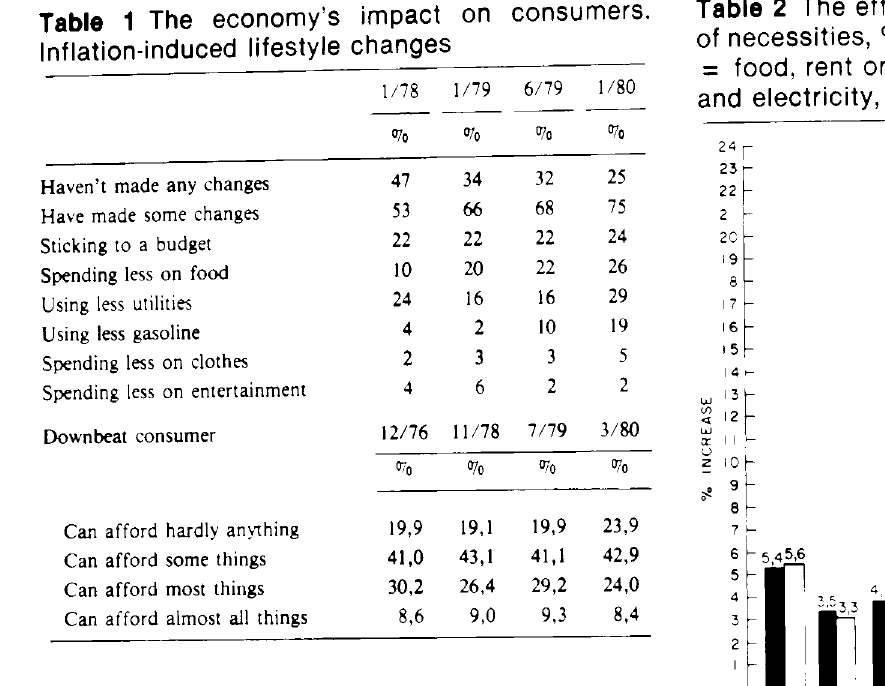
on consumers. Table 2 The effect of inflation: the increasing cost Table 1 The economy's impact of necessities, % increase, year-to-year. Necessities = food, rent or mortgage payments, gasoline, fuel and electricity, and medical